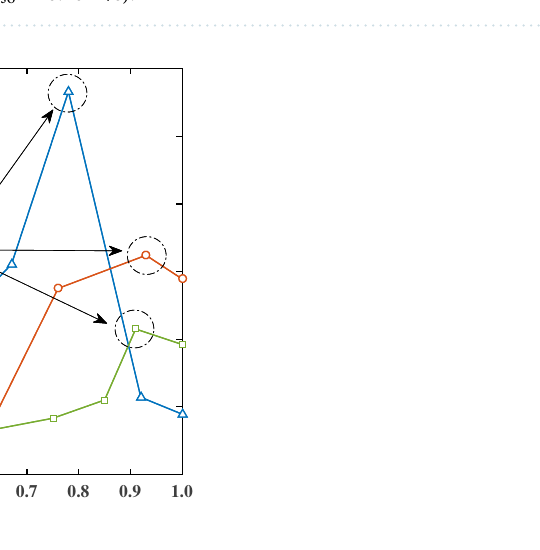
Figure 6. Scaled pressure drop as function of the oil holdup α o for three different total superficial velocities. The phase inversion occurs at an oil holdup between 0.75 and